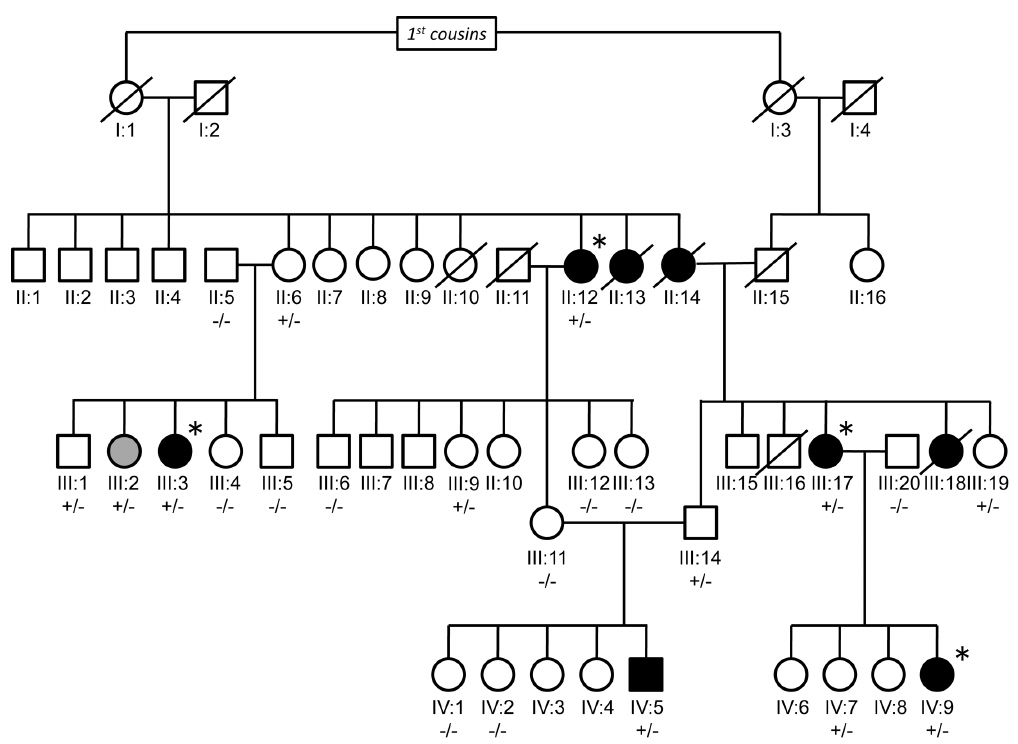
Figure 2. The consanguineous pedigree with Mendelian form of RA. The consanguineous pedigree consists of 49 individuals from 4 generations. The pedigree included 8 individuals affected with RA (colored in black) and 1 ACPA-positive unaffected subject subject (colored in gray). Four RA cases for whom whole-exome sequencing was conducted were indicated with asterisks. Genotypes of the identified PLB1 p.G755R mutation was indicated by the combination of ‘‘ + ’’ (mutated allele) and ‘‘-’’ (reference allele).